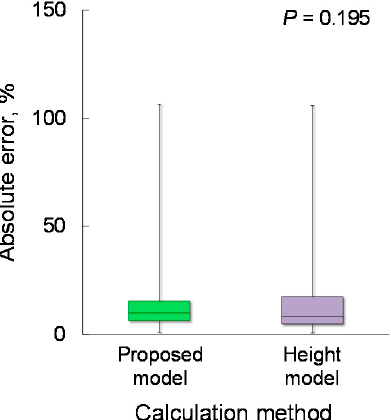
Figure 8. Comparison of the absolute error of the proposed and height models. n = 58.